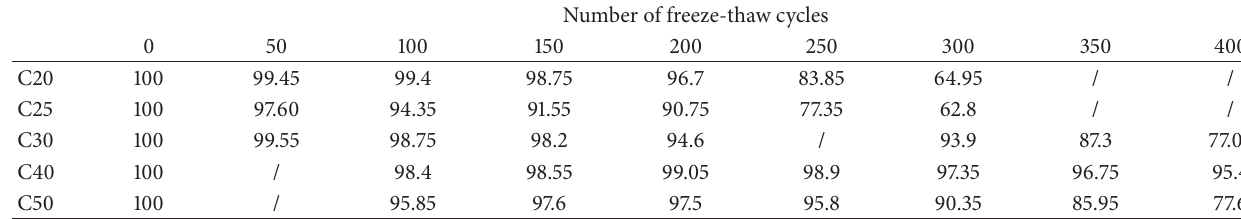
Table 2: RDME of air-entrained concrete after different cycles of freeze-thaw (%).